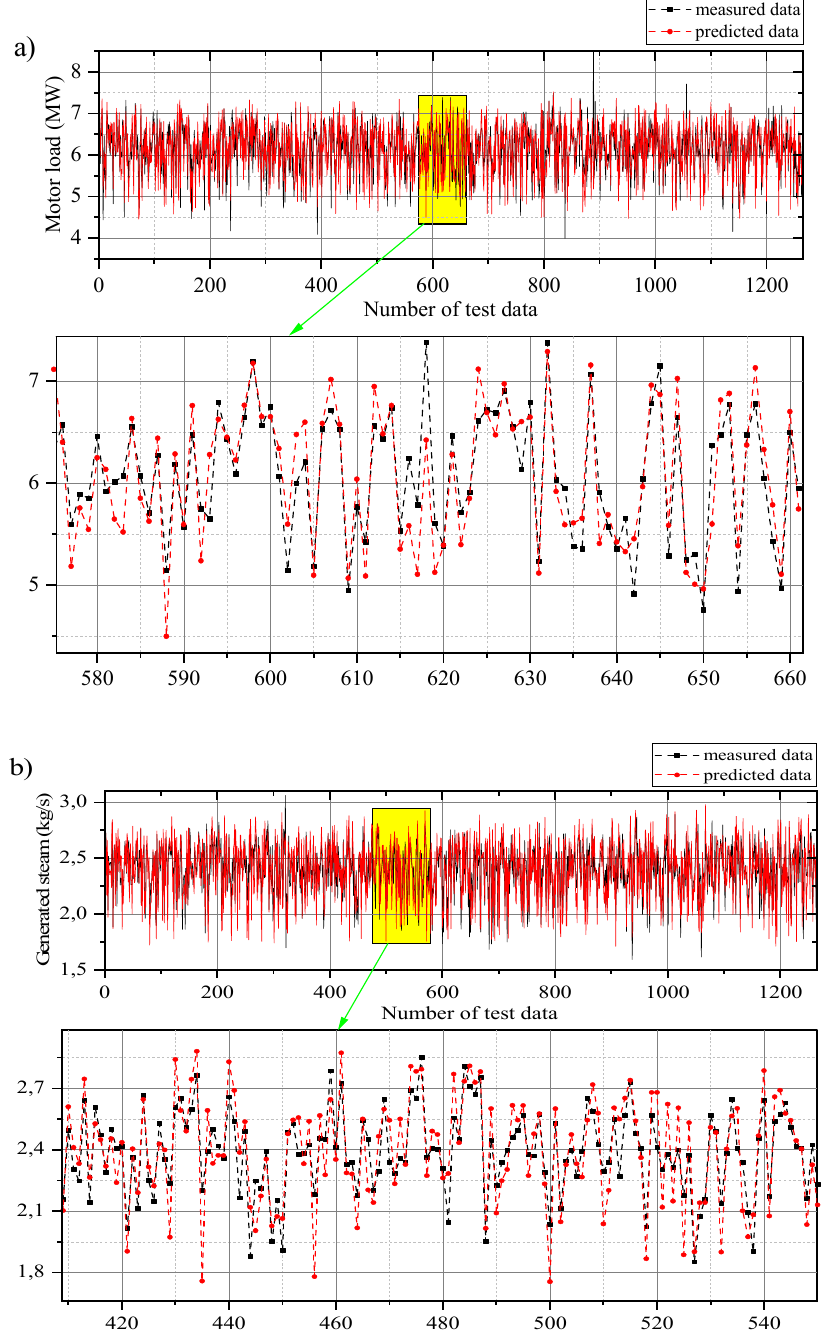
Figure 13. Testing dataset of BBO for predicting motor load ( a ), and produced steam during the pulp refining process ( b ).